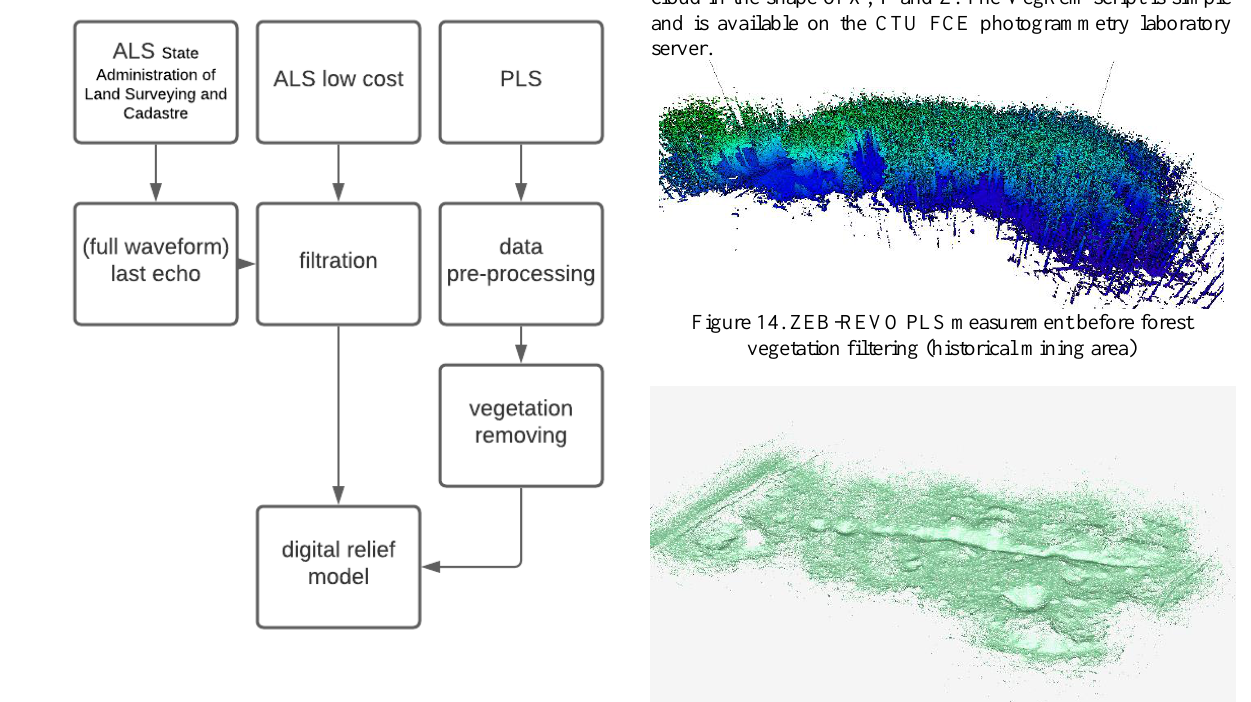
Figure 13. Data processing flowchart